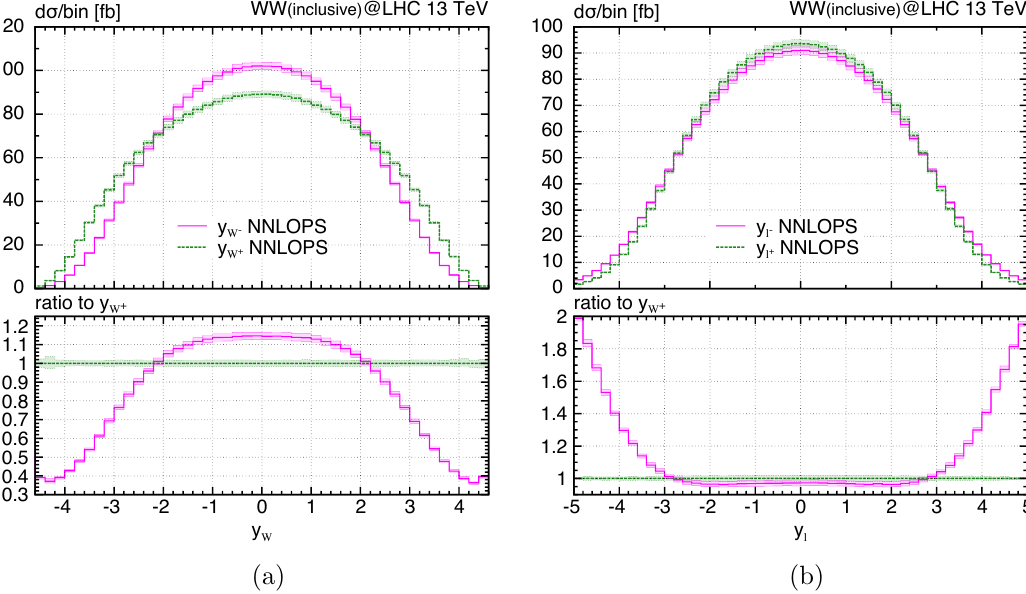
Figure 11 . Comparison of rapidity distributions of negatively (magenta, solid) and positively (green, dotted) charged particles at NNLOPS for (a) the two W bosons and (b) the two leptons. tributions of the positively and negatively charged W bosons as shown in (cid:12)gure 11 (a): W + bosons are generally more forward, while W (cid:0) bosons are situated more at central